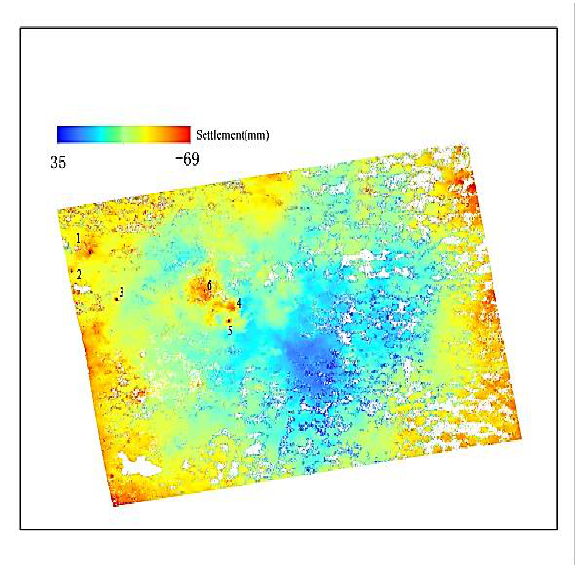
Figure 4. Cumulative deformation of the study area